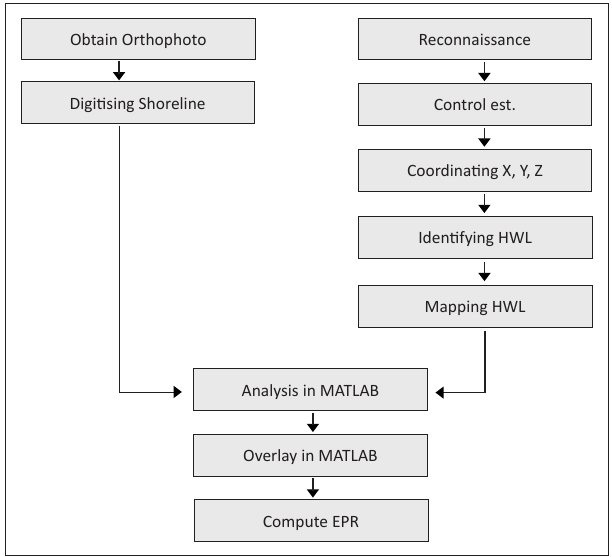
FIGURE 3 : A flow chart of the processes employed in study (HWL = high water line).